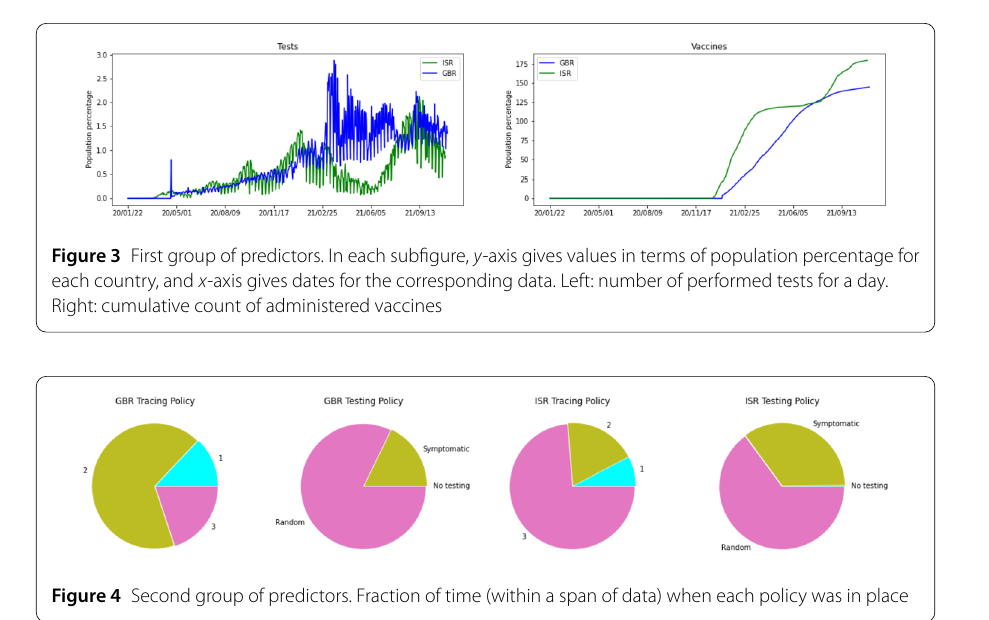
Figure 4 Second group of predictors. Fraction of time (within a span of data) when each policy was in